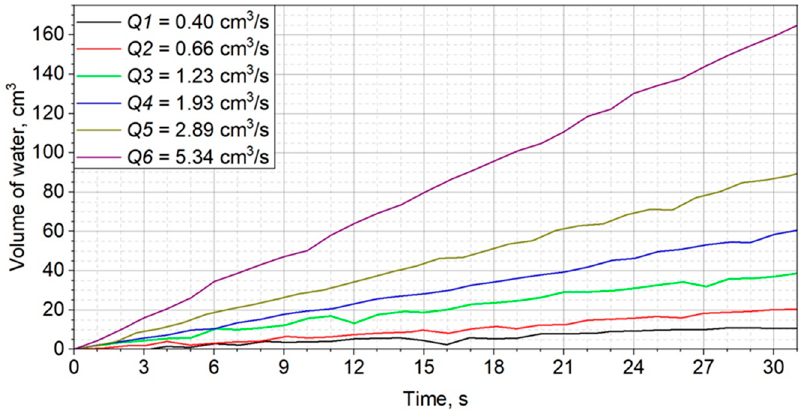
Figure 2. Manometer readings converted into water volume and volume flow in the range of 0.4–5.34 cm 3 /s.